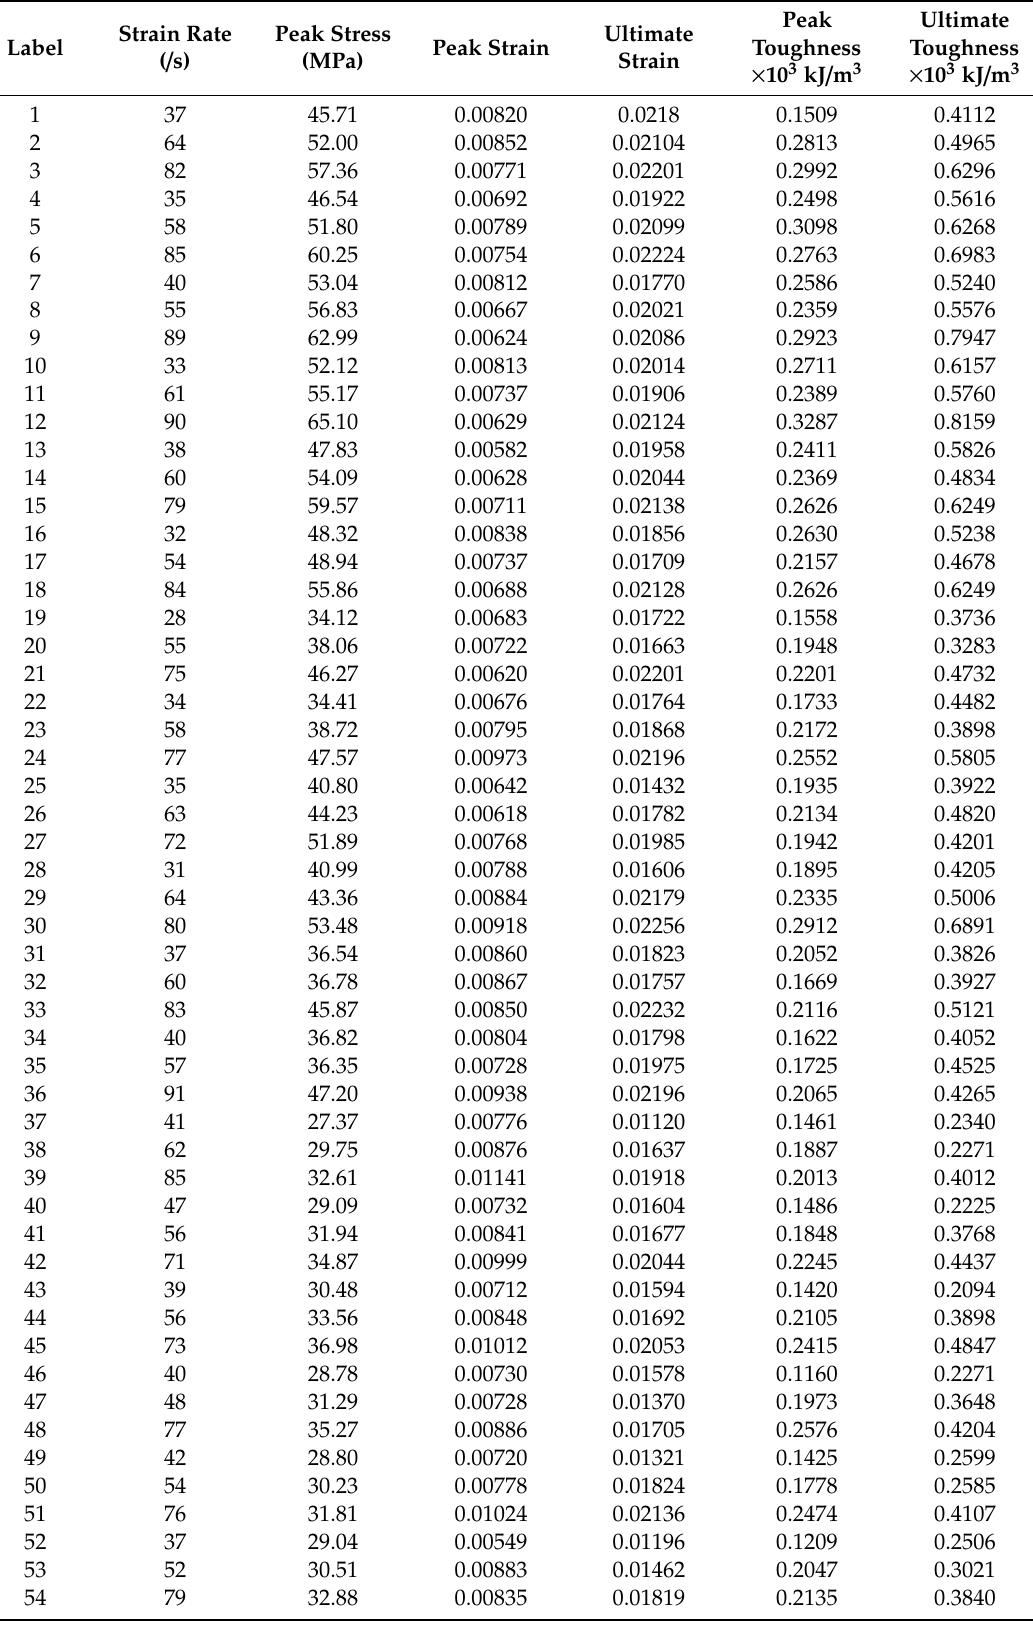
Table 4. The dynamic characteristic parameters of BSFRC in the SHPB